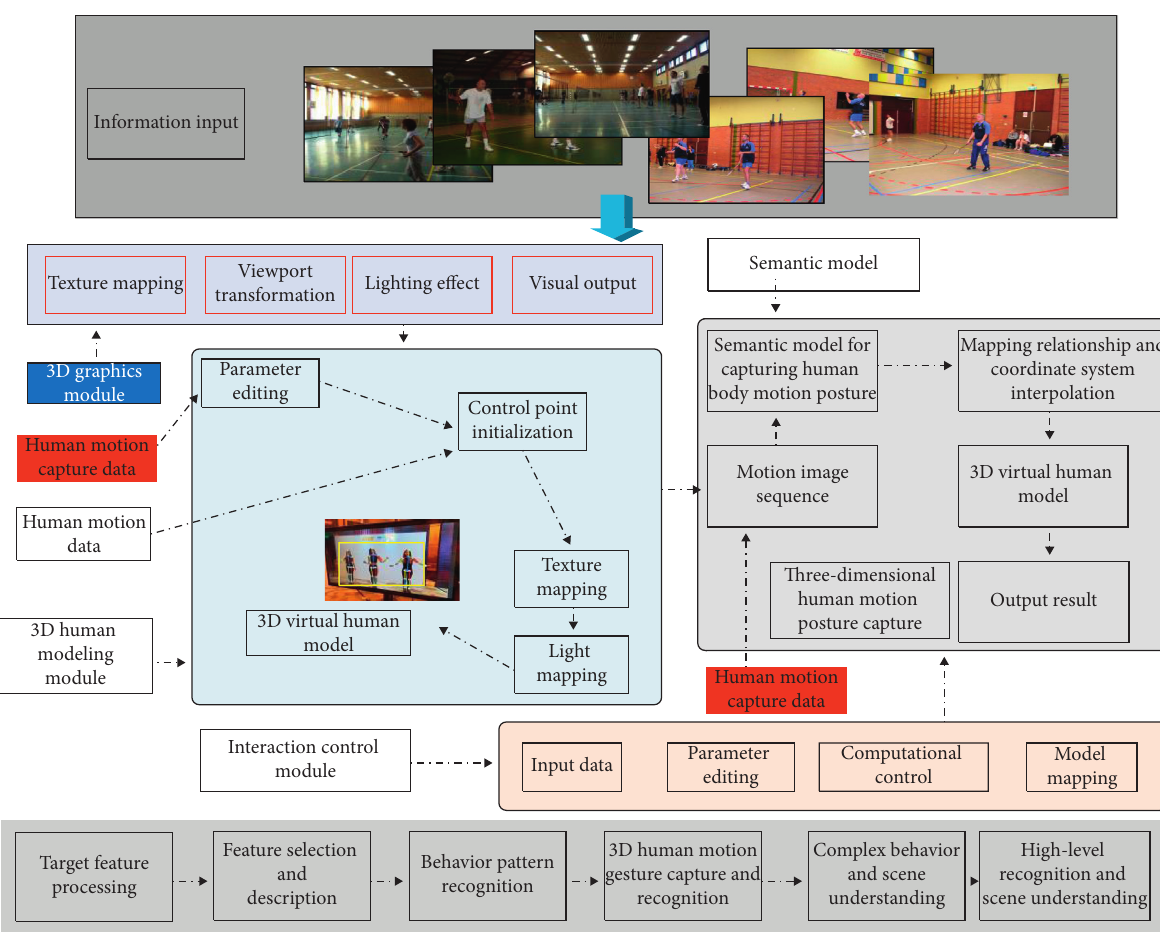
Figure 2: Frame diagram of human motion posture